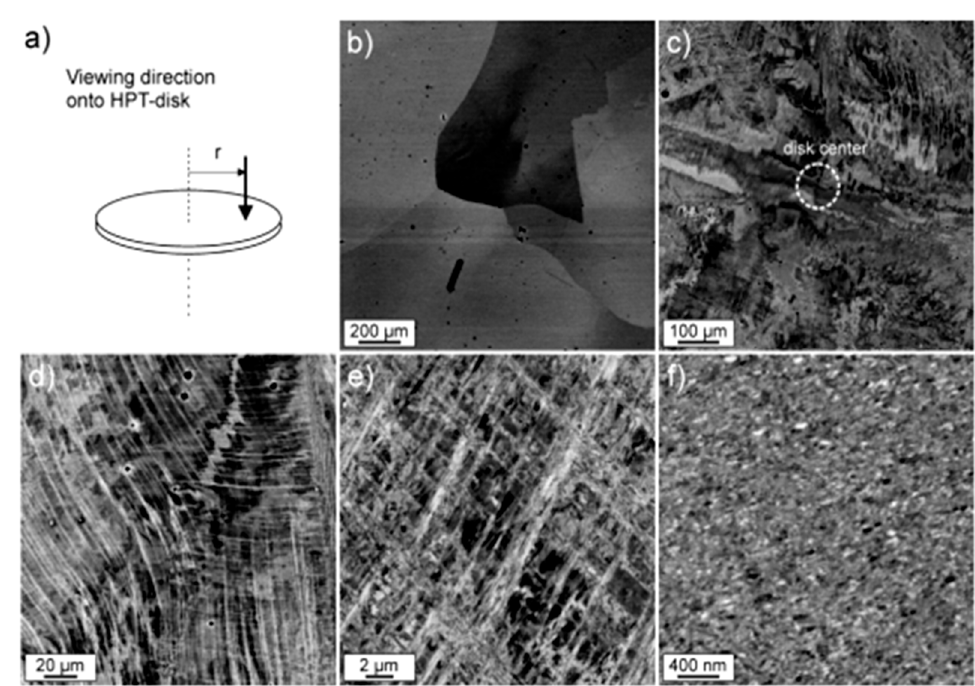
Figure 9. Microstructural evolution in HPT disks investigated with SEM using back-scattered electron contrast, reproduced from [66], with permission from authors.